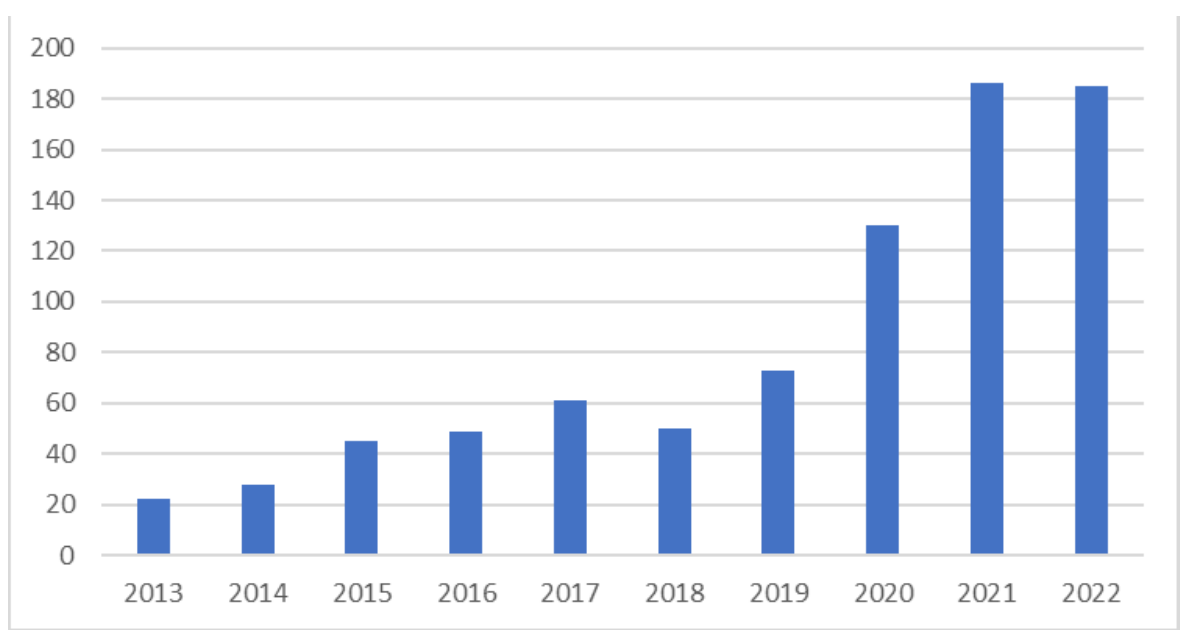
Figure 2. Number of articles published in the years 2013 – 2022.